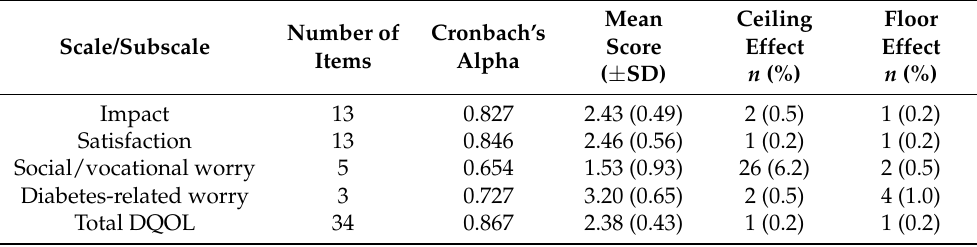
Table 5. The internal consistency, ceiling, and floor effects of the DQOL-AO version among people living with type 2 diabetes attending Nekemte Specialized Hospital, 2020 ( n = 417).